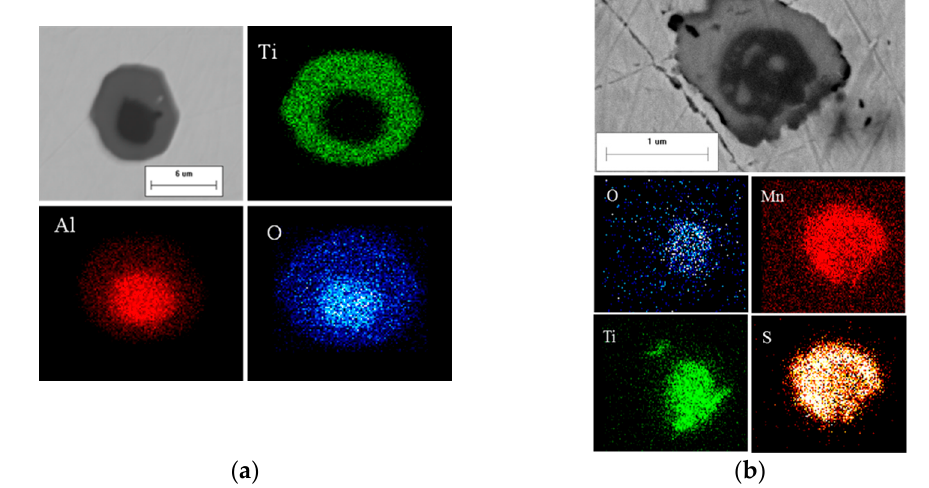
Figure 5. Typical heterogeneous inclusions in steel B: ( a ) Al 2 O 3 -TiO x and ( b ) TiO x -MnS [15]. with permission from [15], ISIJ International,